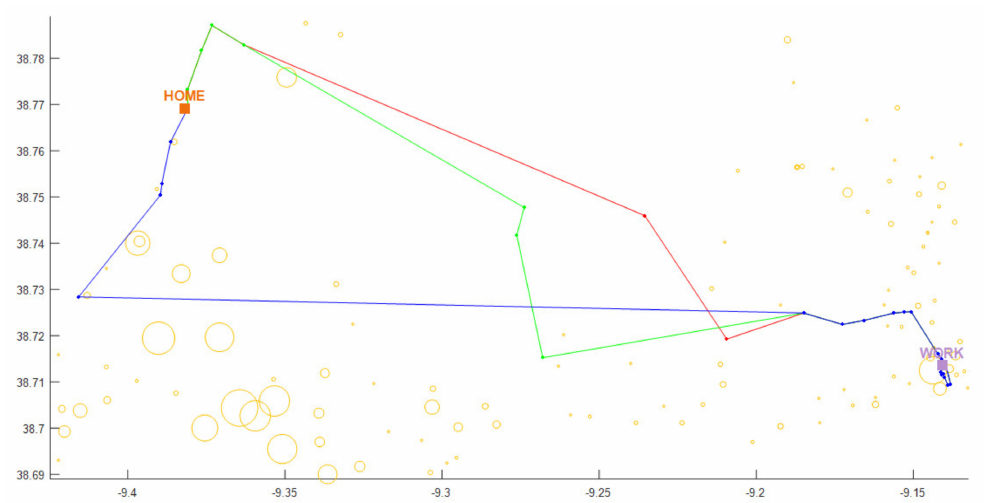
Figure 3. An example of route choices between home and workplace plotted along with the locations of connected cell towers where the circle size corresponds to the total amount of connections.